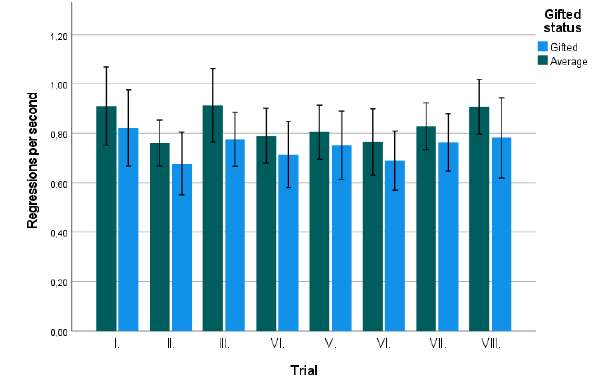
Figure 4. Mean fixation durations in gifted and average children across individual trials. Error bars mark 95% CI.